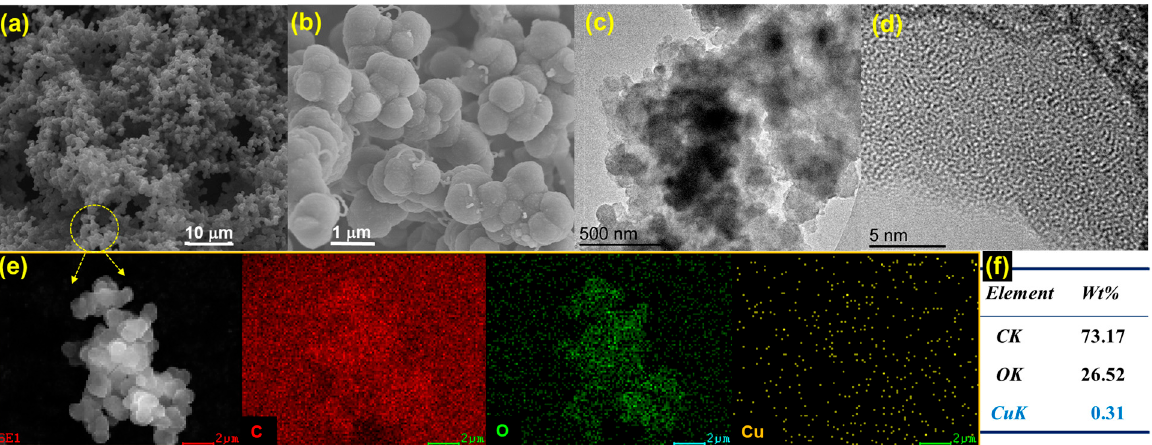
Figure 5. Microscopic structures and compositions of the LRF carbon cryogel (DES1:5+5%MOF): ( a , b ) SEM images; ( c , d ) TEM and HRTEM images; ( e , f ) elemental content by EDS mapping.